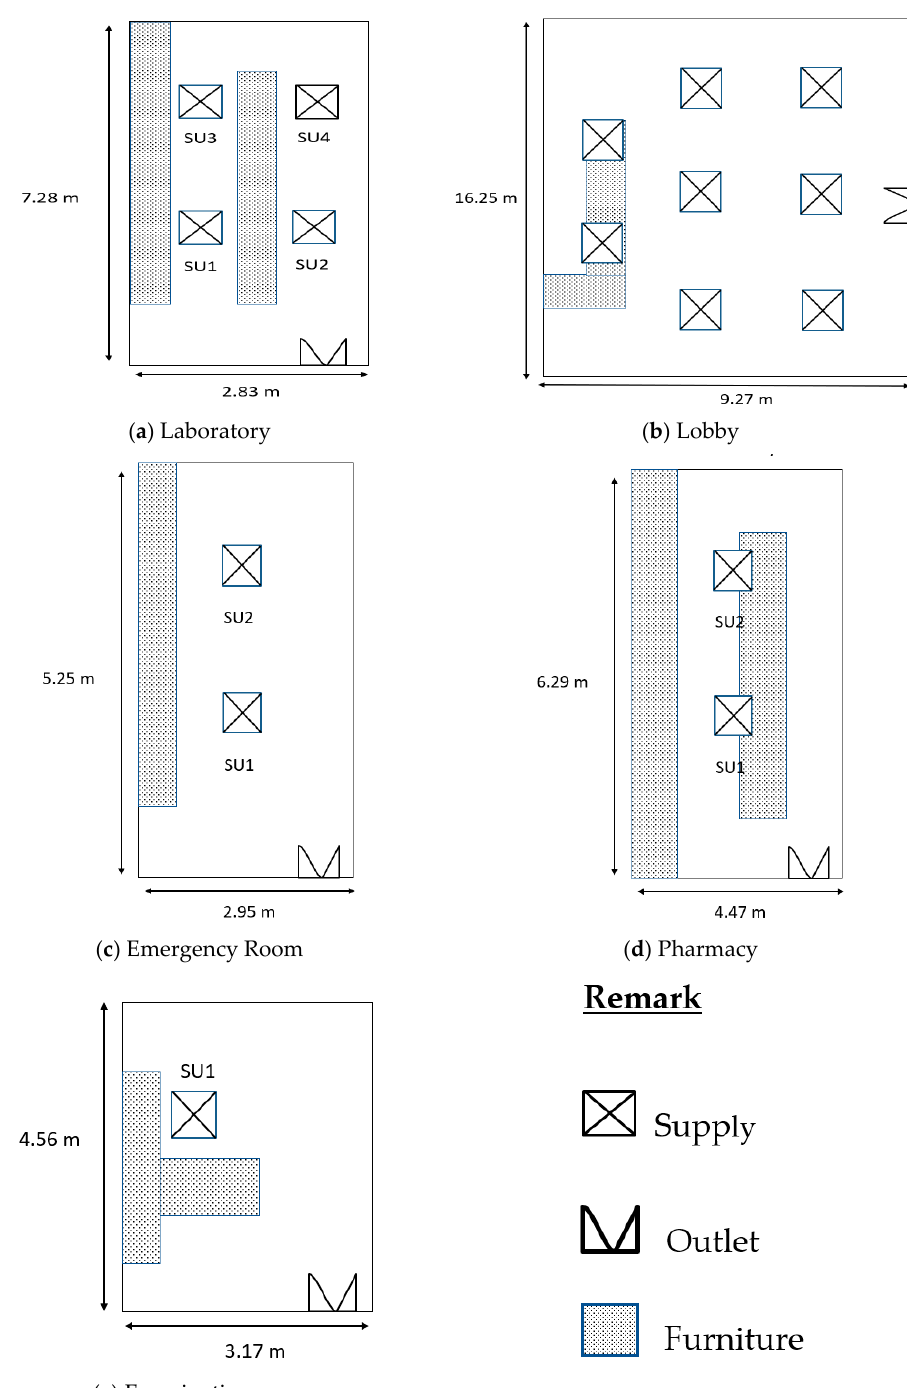
Figure 1. Health clinic floor plan. ( a ) room volume (area(m 2 ) × height) = 7.28 m × 2.83 m × 3.00 m = 61.81 m 3 , ( b ) room volume (area (m 2 ) × height) = 16.25 m × 9.27 m × 3.00 m = 451.91 m 3 , ( c ) room volume (area (m 2 ) × height) = 5.25 m × 2.95 m × 3.00 m = 46.46 m 3 , ( d ) room volume (area (m 2 ) × height) = 6.29 m × 4.47 m × 3.00 m = 84.35 m 3 , ( e ) room volume (area (m 2 ) × height) = 4.56 m × 3.17 m × 3.00 m = 43.37 m 3 .